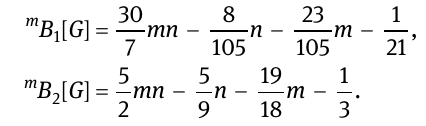
Table 1: Degree - based partition of edges of Si C 2 3 - n m III , [ ] u v d , d ( ( ) (